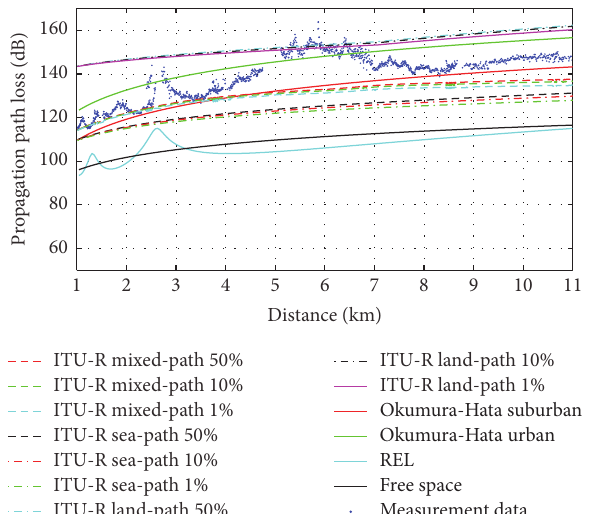
Figure 24: The simulation of classic radio propagation path loss models based on measurement data 1.